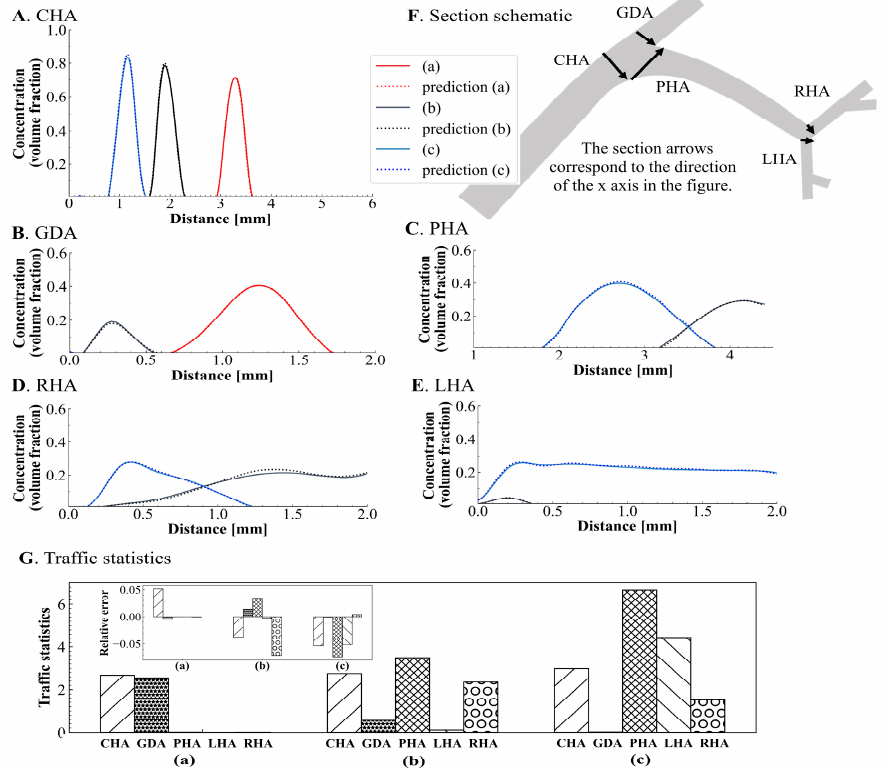
Figure 8. ( A – E ) Drug concentration profile along the specified cross-sections in the human hepatic artery; ( F ) schematic diagrams of the specified cross-sections corresponding to ( A – E ); ( G ) statistics of the total amount of drug in the cross-sections.